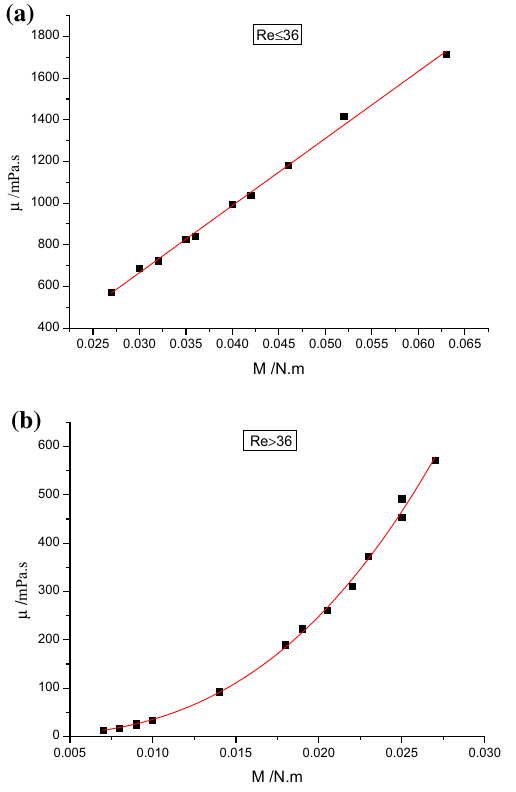
Fig. 2 The viscosity-torque curve at 400